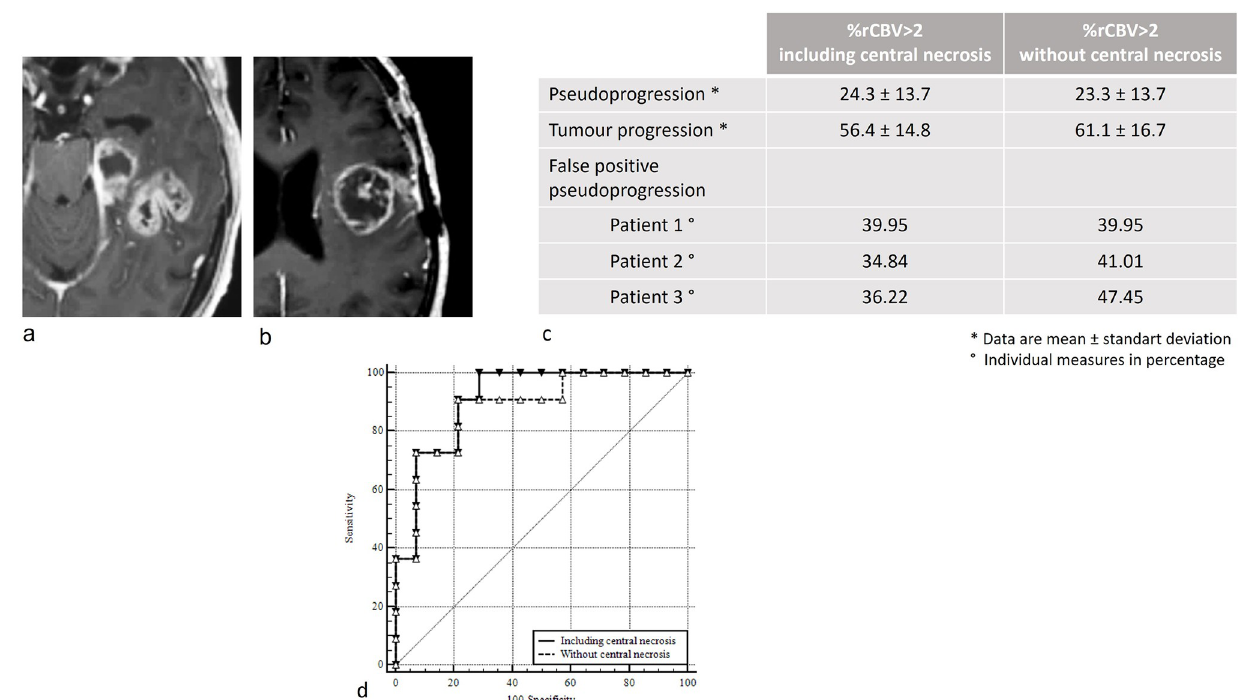
Fig 6. Pseudoprogression diagnosis accuracy of %rCBV > 2 after exclusion of the central necrosis. Axial contrast-enhanced T1-weighted images (CE-T1WI) of early follow-up MRI of two morphologically different false positive (FP) pseudoprogression (PsP): (a) partially necrotic and (b) mostly necrotic. Table (c) presents %rCBV > 2 mean measurements of %rCBV > 2 in the PsP and tumour progression groups and individual measures for FP PsP patients, before and after exclusion of the central necrotic component from perfusion analysis and ROC curves comparison (d) for the diagnosis of PsP shows no statistical